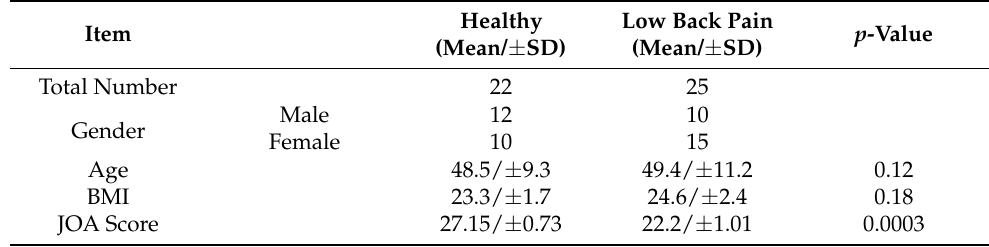
Figure 1. Flow Chart. Table 1. Demographic data and JOA